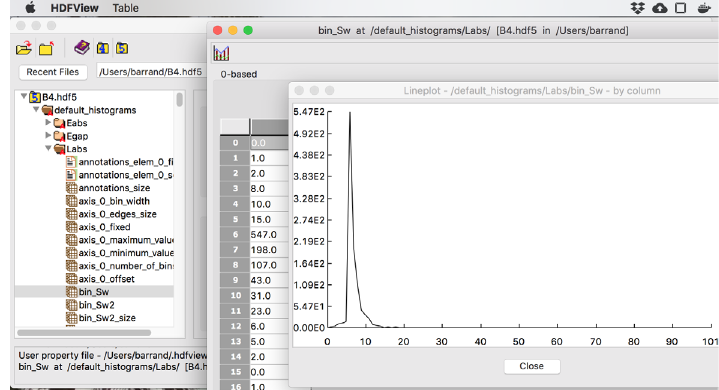
Figure 1. HDFView of the B4 HDF5